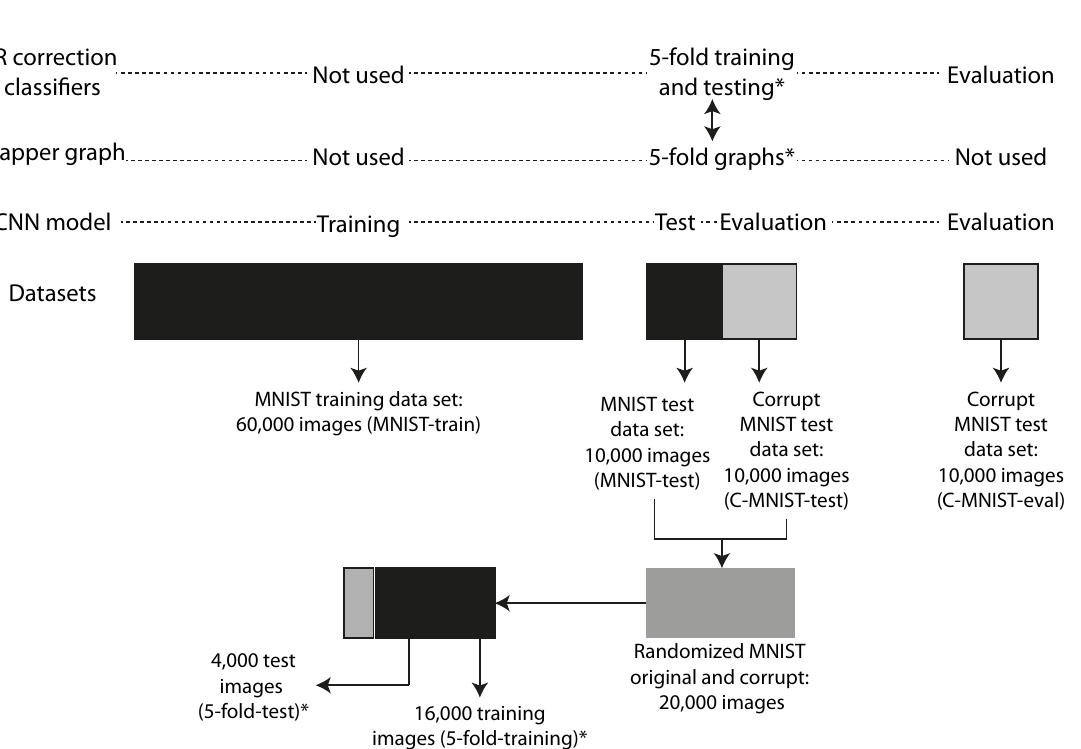
Figure 5. An illustration how all datasets relate to all steps in F I F A for the MNIST model case. The asterisk (*) marker emphasizes that the 5 M APPER graphs and the corresponding LR correction classifiers were created using 5 folds of a randomized combination of the MNIST-test and C-MNIST-test datasets. These datasets are shown in the bottom of the figure. The names in parentheses are the names of the datasets as they are referred to in the text and subsequent figures and tables.